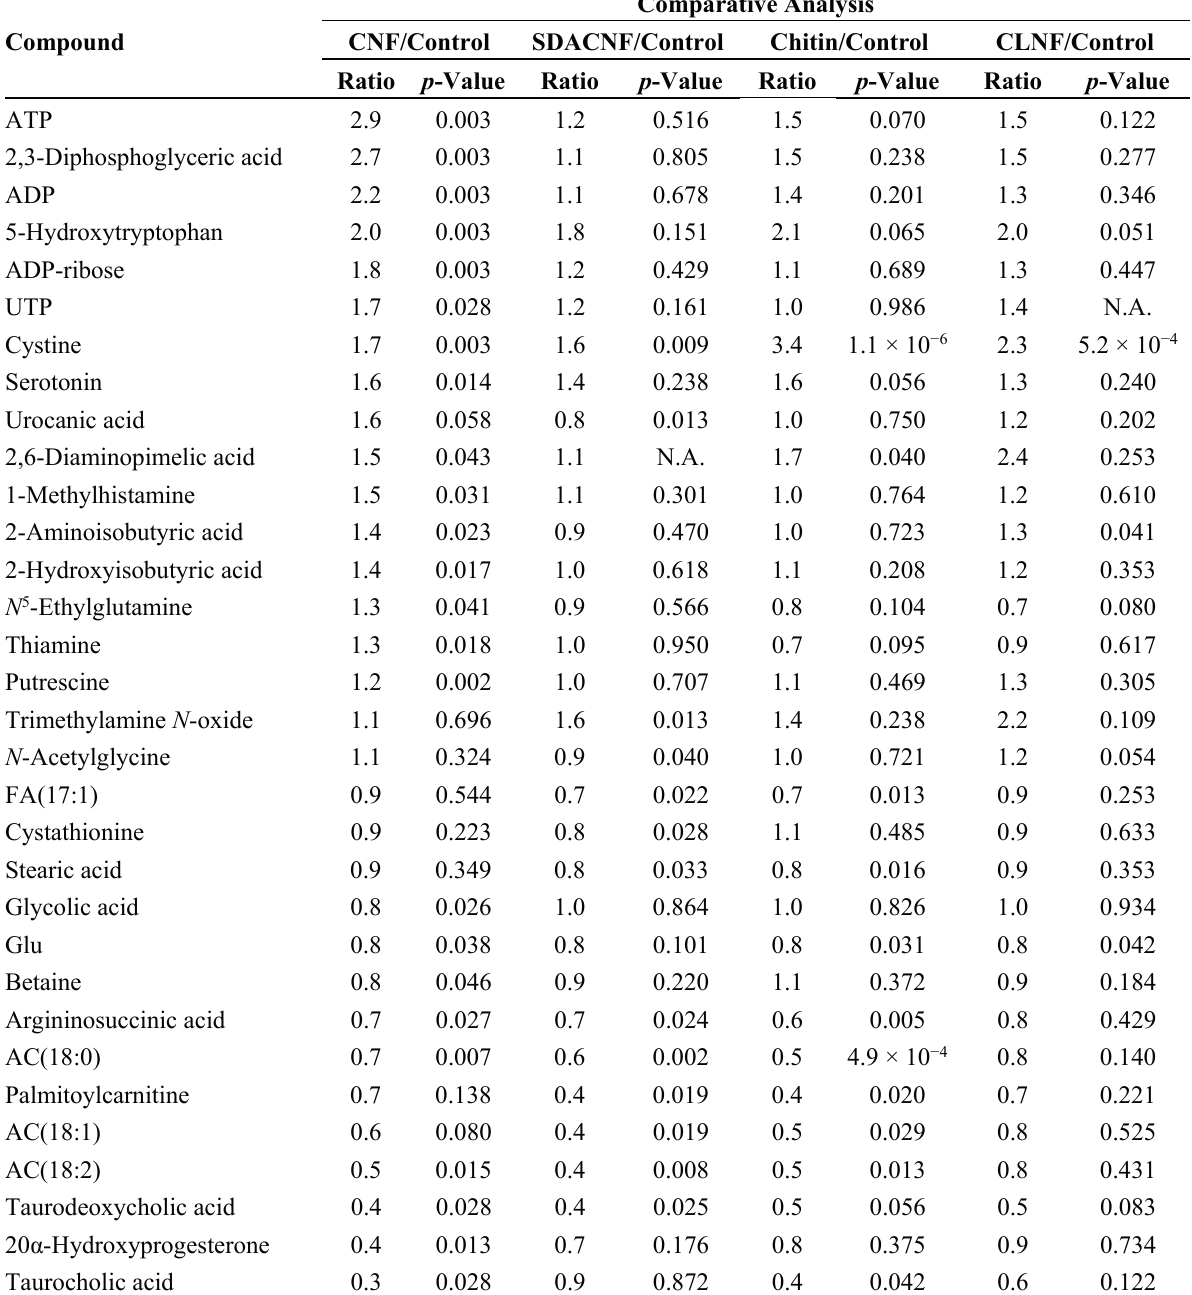
Table 1. Ratios of relative areas of nanofiber metabolites to control